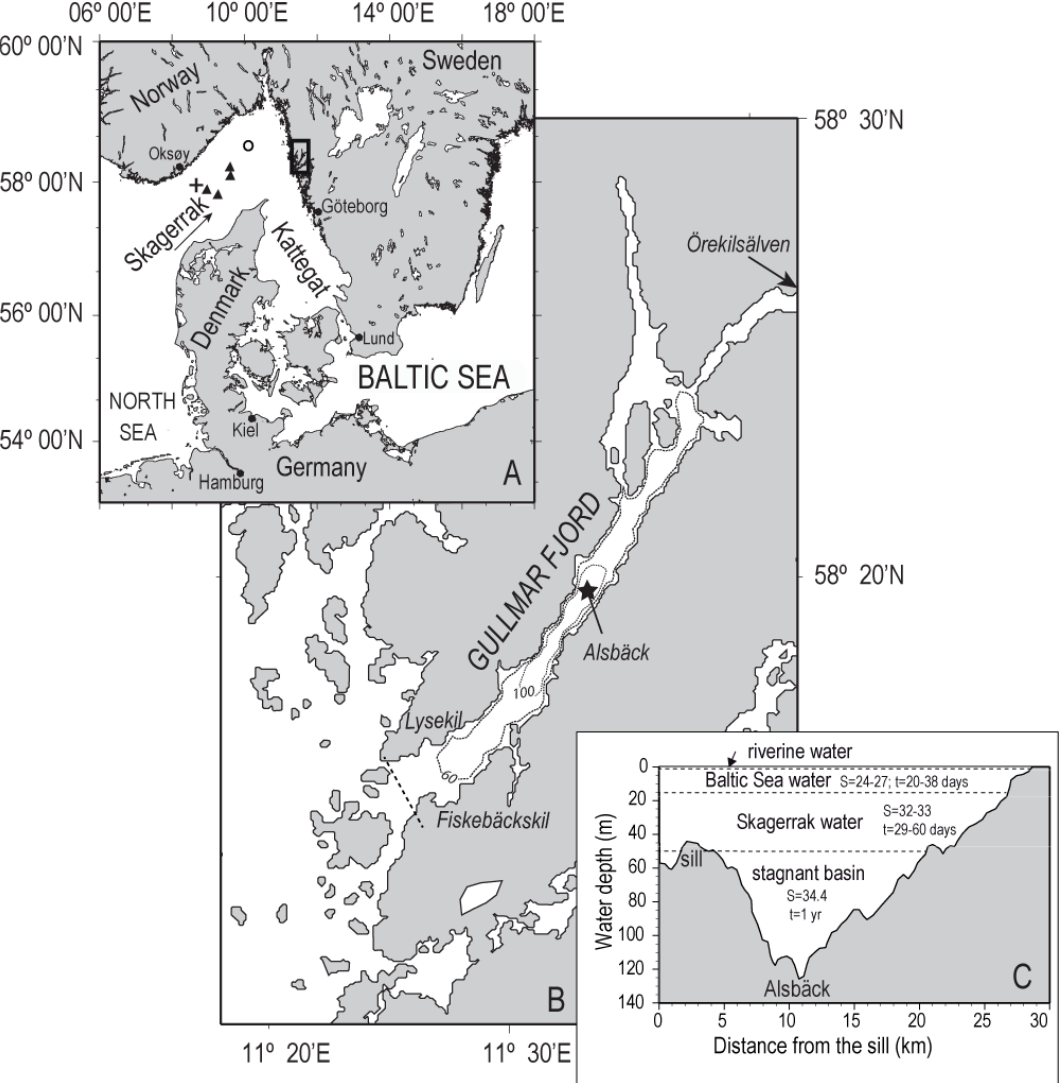
Fig. 1. Overview map of the study area. (A) A rectangle shows the location of Gullmar Fjord in the Skagerrak area; the positions of sedimentary archives used by previous studies are indicated as a circle and a plus for cores studied by Erbs-Hansen et al. (2011) and Br¨uckner and Mackensen (2006), correspondingly, whereas black triangles are sediment cores studied by Hass (1997). (B) Overview of the Gullmar Fjord area; a star in the deepest basin (Alsb¨ack) indicates sampling site for cores GA113-2Aa, 9004 and GA113-091; a dashed line in the outer fjord indicates location of the sill. (C) Overview of water masses in the longitudinal profile of the Gullmar Fjord with indication of salinity ( S ) and residence times ( t ) typical for each water layer (Arneborg,